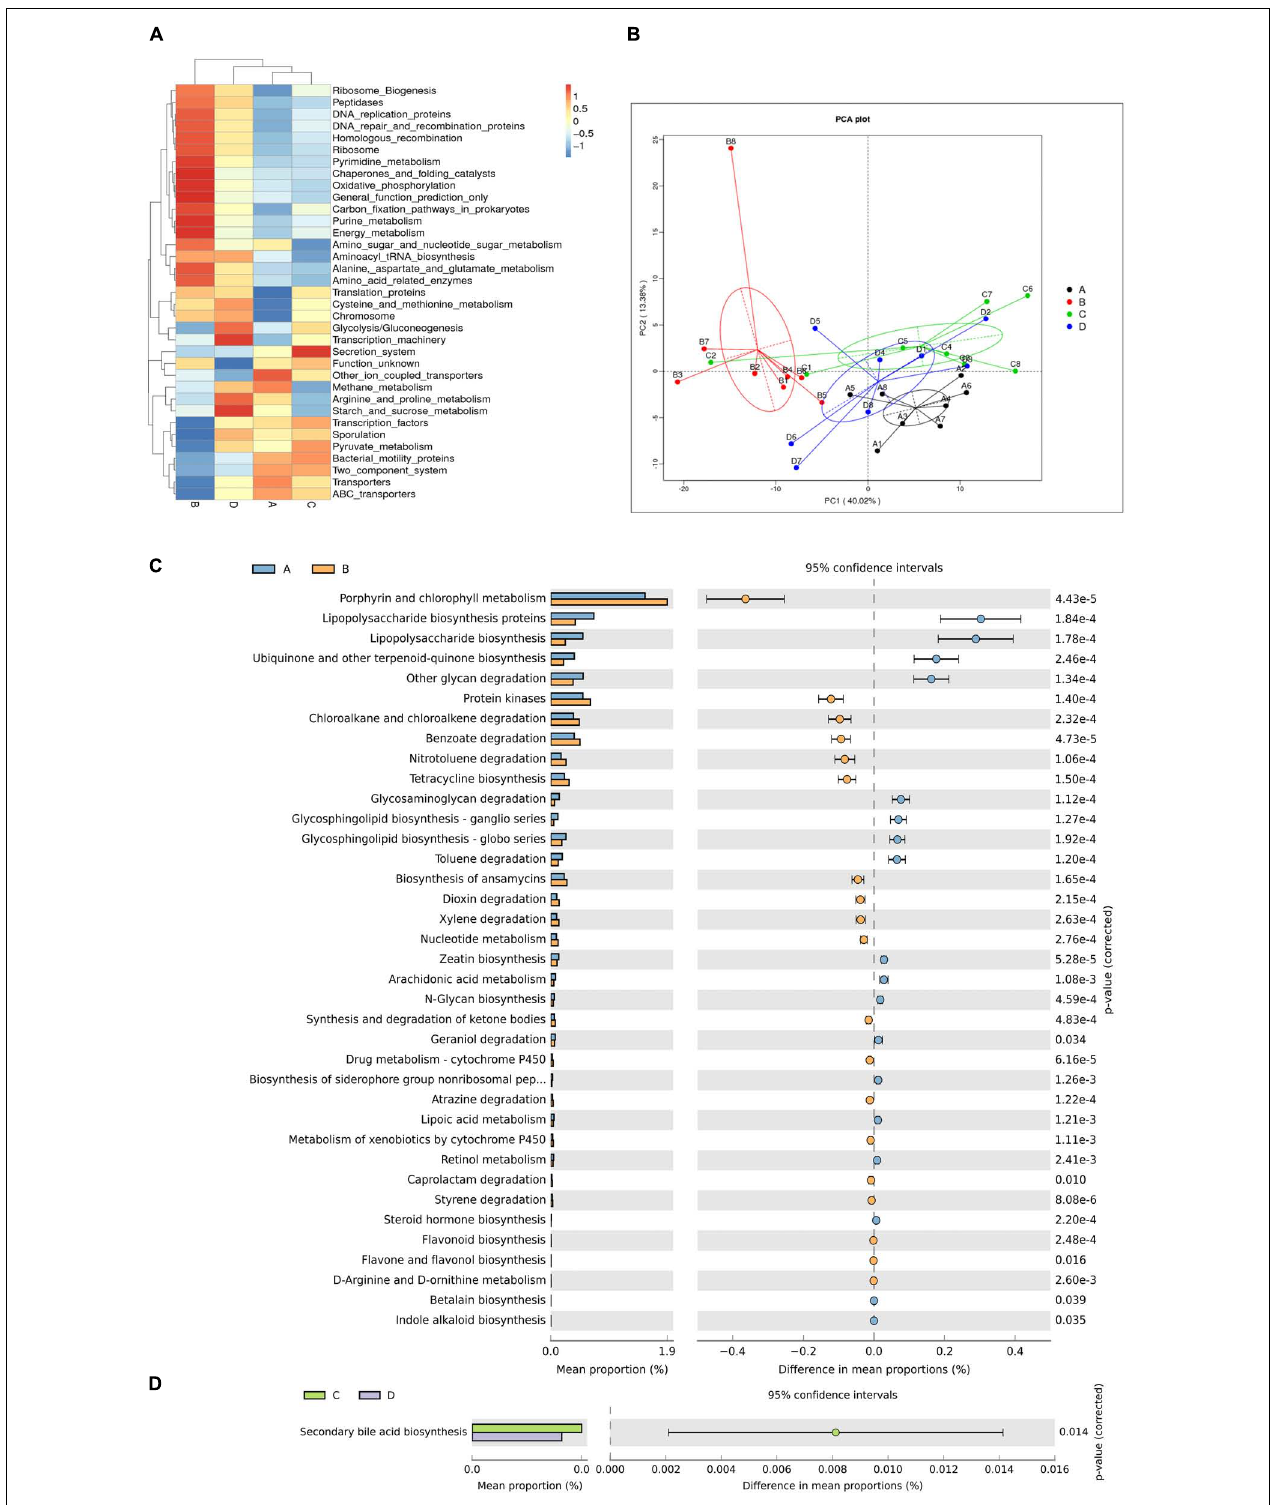
FIGURE 5 | Differences in metabolic functions of gut microbiota. (A) Heatmap showing significantly different functional pathways. (B) Principal components analysis (PCA) plot of functional profiles among groups. (C,D) T -test bar plot of significantly differed metabolic pathways. n = 6. A, C: sows with high productive capacity (HPC) at late pregnancy (LP) and early stage after parturition (EAP) separately; B, D: sows with low productive capacity (LPC) at late pregnancy (LP) and early stage after parturition (EAP) separately.